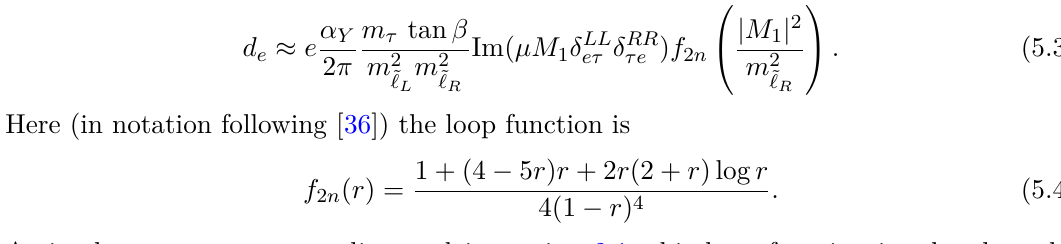
and δ RR , which will in general carry O (1) CP- eτ τe